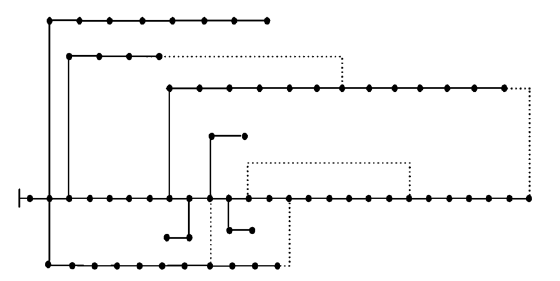
Fig. 9: One-Line Diagram of IEEE 69-Bus Radial Network In the normal operating condition, switches in the branches 69, 70, 71, 72 and 73 are unlocked. Similar